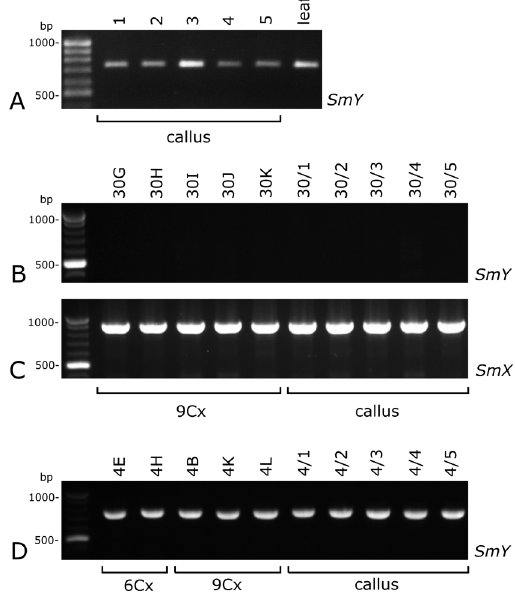
Figure 5. Amplification bands of SmY in leaf-derived callus from the male Actinidia chinensis var. deliciosa cv. Tomuri ( A ) endosperm-derived callus line number 30 ( B ) line number 4 ( D ) and plants regenerated from their respective calli ( B , D ). No SmY amplified bands indicates a female charac- teristic of a callus and 9Cx regenerants ( B ). Male characteristic of callus ( A ), 6Cx and 9Cx regen- erants ( D ). Amplified bands of SmX as positive control ( C ).